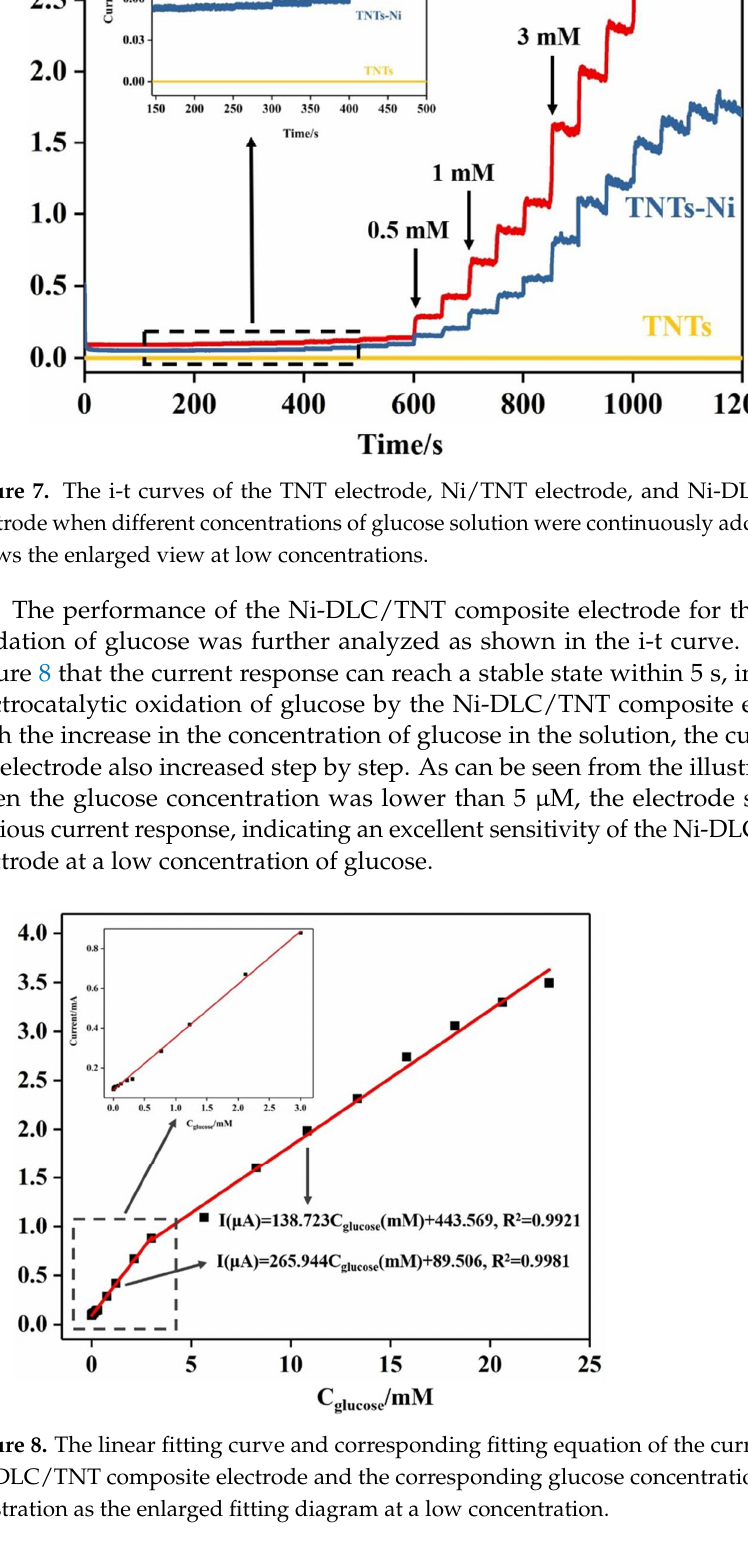
Figure 8. The linear fitting curve and corresponding fitting equation of the current response of the Ni-DLC/TNT composite electrode and the corresponding glucose concentration are shown in the illustration as the enlarged fitting diagram at a low concentration.